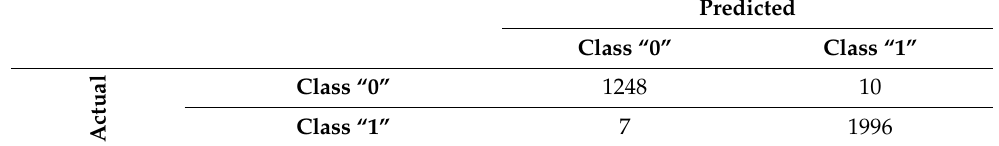
Table 15. Confusion matrix for SVM.